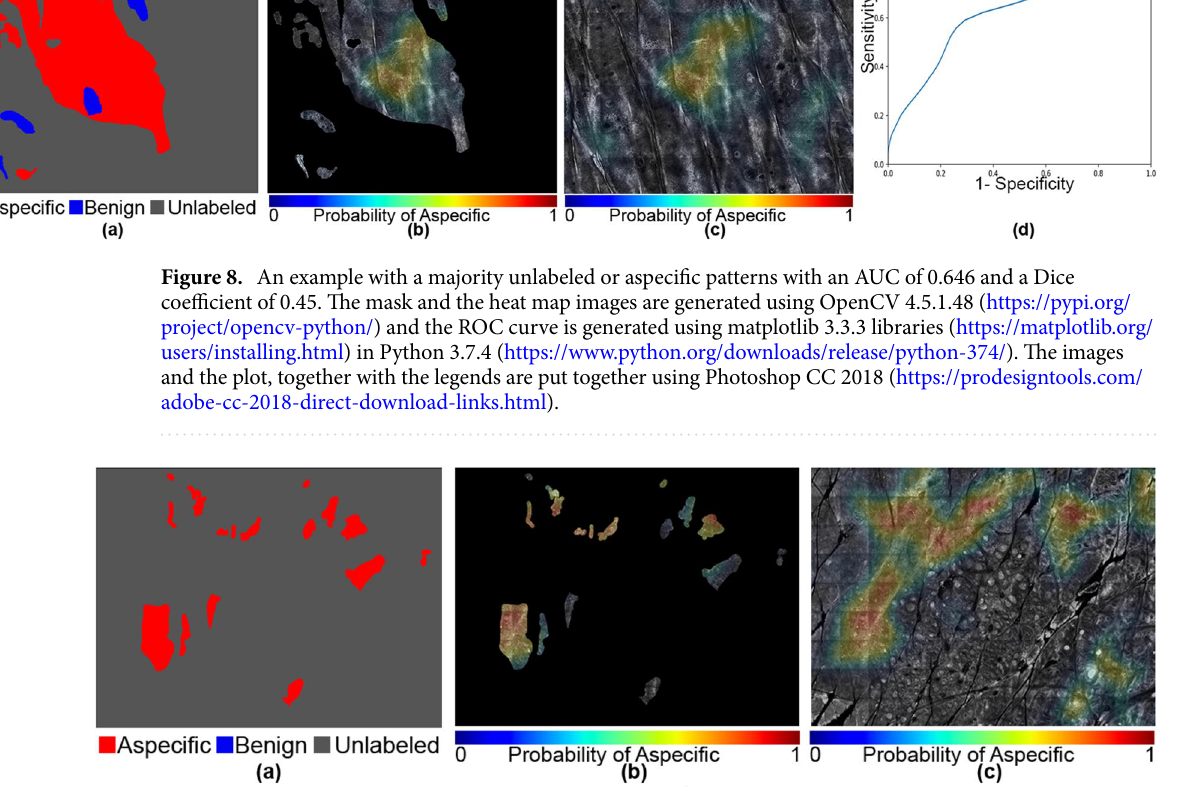
Figure 9. An example with no benign patterns and a Dice coefficient of 0.75. The mask and the heat map images are generated using OpenCV 4.5.1.48 (https ://pypi.org/proje ct/openc v-pytho n/) library in Python 3.7.4 (https ://www.pytho n.org/downl oads/relea se/pytho n-374/). The images and the legends are put together using Photoshop CC 2018 (https ://prode signt ools.com/adobe -cc-2018-direc t-downl oad-links .html).